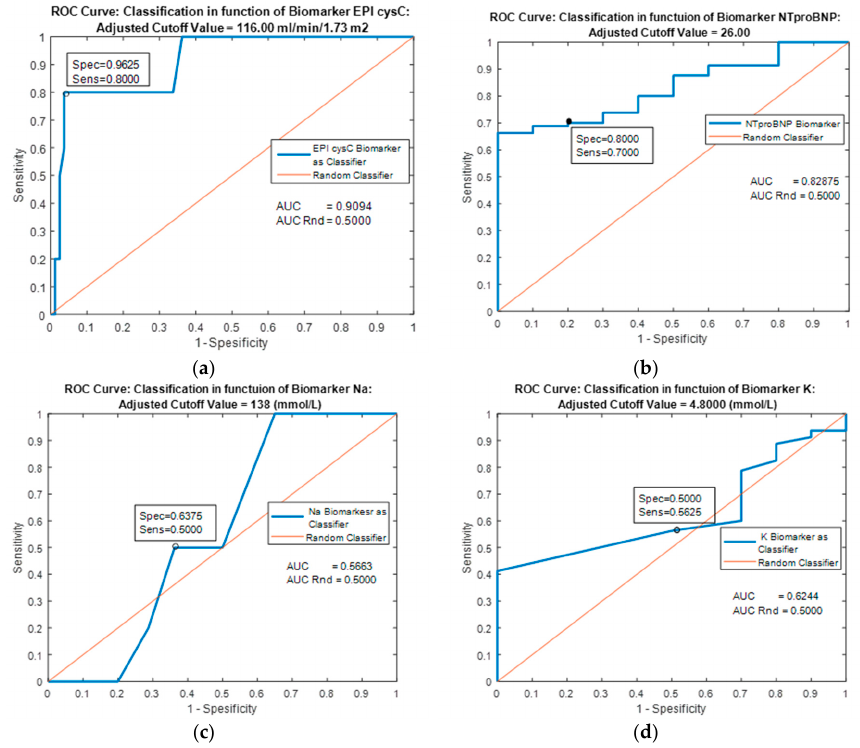
Figure 2a. The diagonal line refers to the classifier with random class selection.